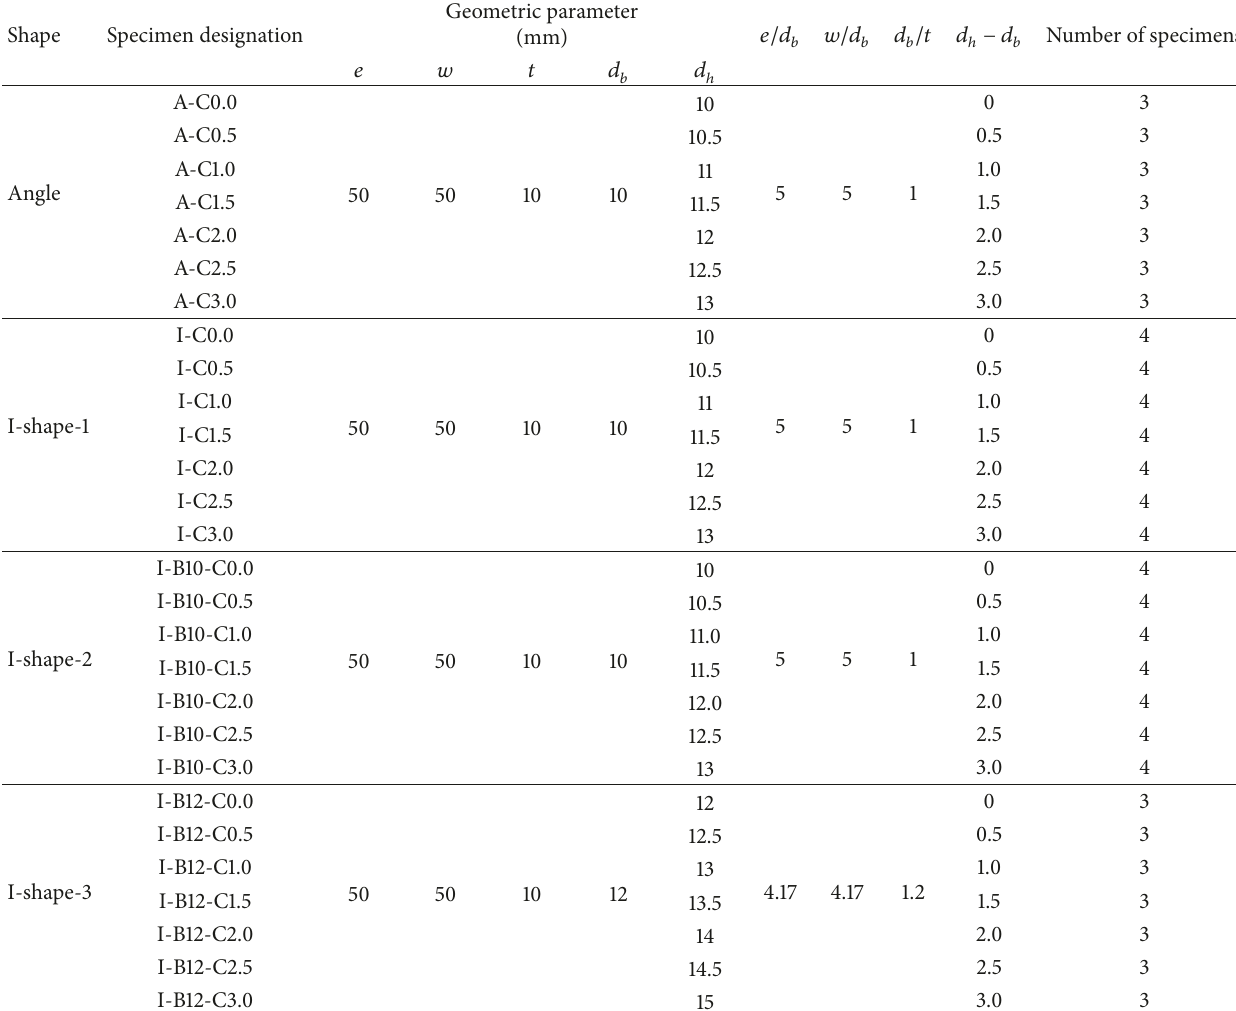
Table 2: Dimensions of test specimens connected with a